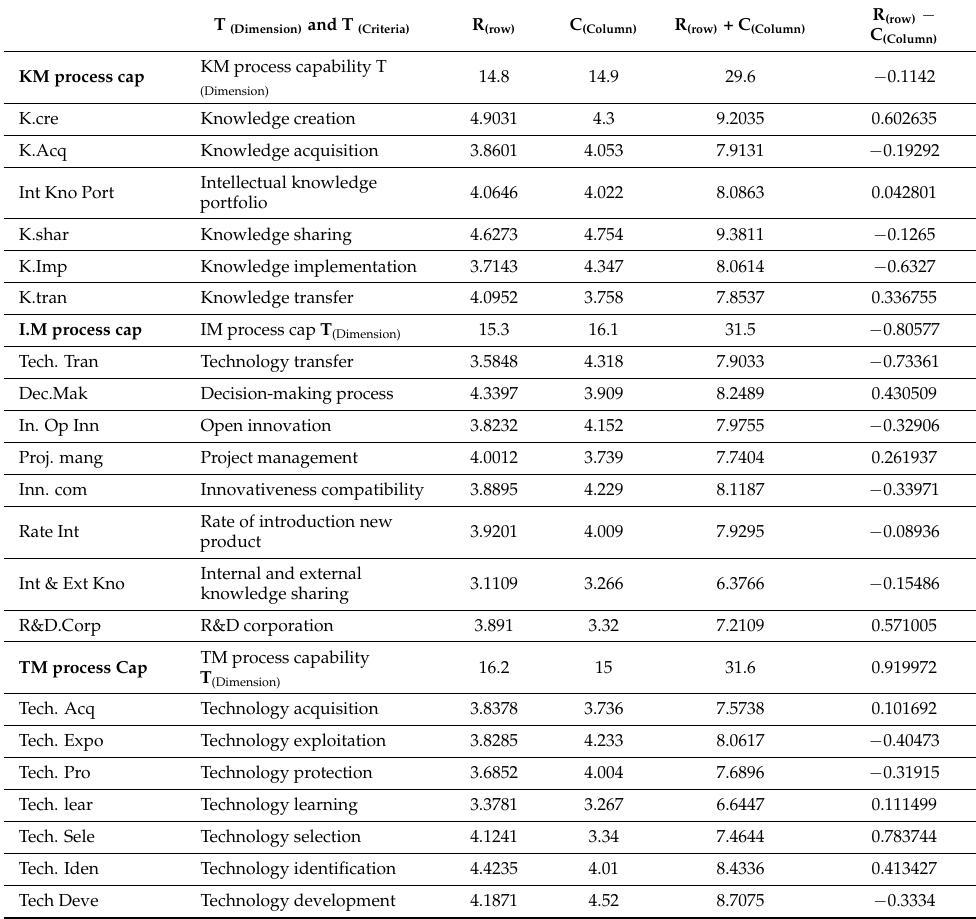
Table 8. Overall effects (given and received) of the total average matrix on T (Dimension) and T (Criteria) . T (Dimension) and T (Criteria) R (row) C (Column) R (row) + C (Column) R (row)